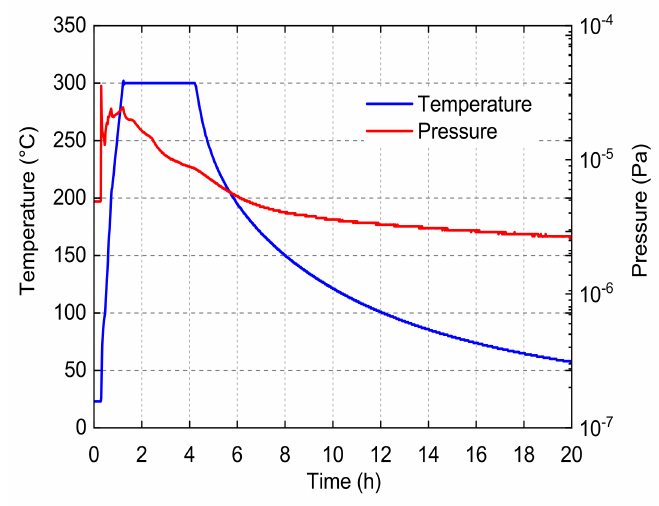
Figure 4. Temperature and vacuum curves during mid-T furnace